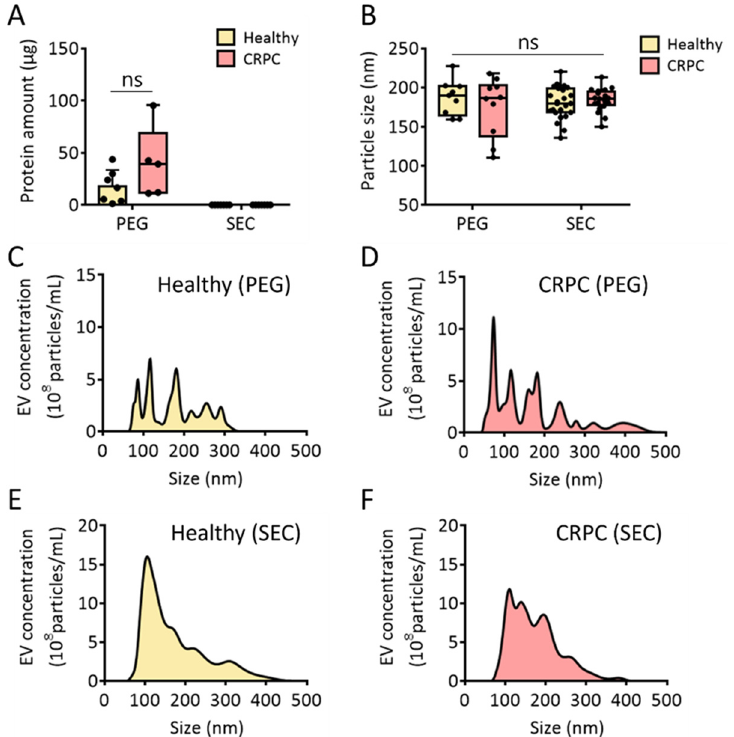
Figure 4. Comparative analysis of urinary EVs isolated via PEG precipitation and size-exclusion chromatography. ( A ) Protein amount (µg) from healthy donors and patients with CRPC. ( B ) Urinary EV particle size (nm) from healthy donors and patients with CRPC. ( C , D ) Urinary EV size distribution from healthy donors and patients with CRPC isolated via PEG precipitation. ( E , F ) Urinary EV size distribution from healthy donors and patients with CRPC isolated via size-exclusion chromatography combined with UF. All values are presented as the median ± SD (ns: no significance; n = 5–24).